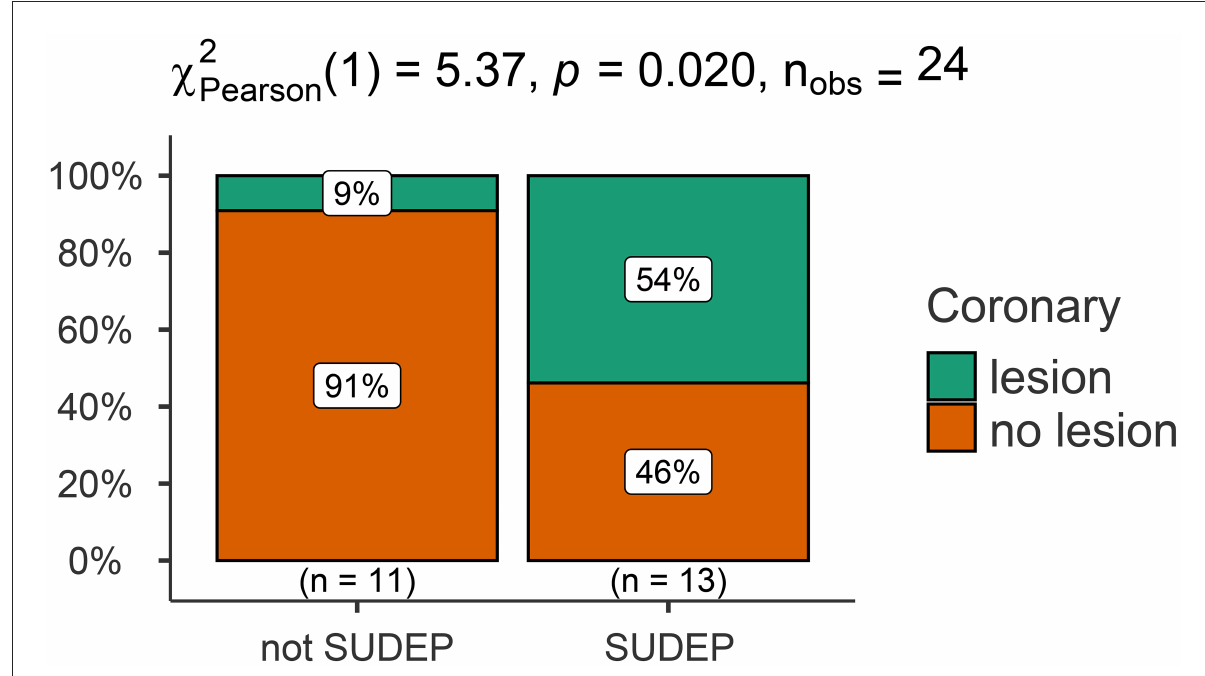
FIGURE3 Comparison of the coronary artery lesions between SUDEP and not-SUDEP